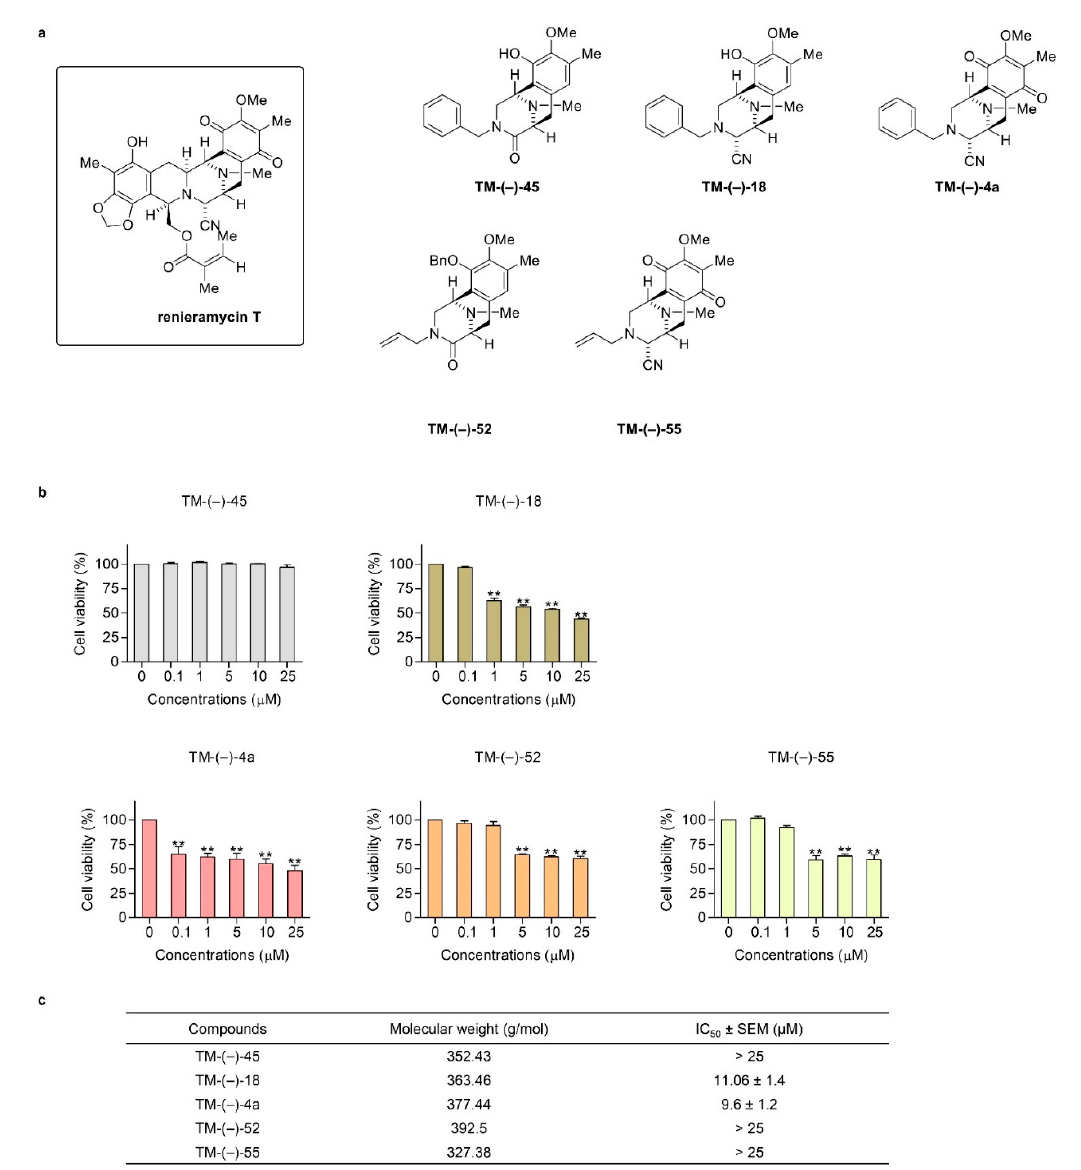
Figure 2. Cytotoxic effects of the simplified right-half model of RT compounds on the NSCLC cell line (H460). ( a ) The structures of RT and the simplified right-half model of RT compounds: TM-(–)-45, TM-(–)-18, TM-(–)-4a, TM-(–)-52, and TM-(–)-55. ( b ) The H460 cell line was treated with 0–25 µM of the compounds for 24 h. Then, the MTT assay was used to determine the percentages of cell viability. ( c ) IC 50 values in each cell line were calculated in comparison to the untreated control. Data represent the mean ± SEM ( n = 3) (* 0.01 ≤ p < 0.05, ** p < 0.01, compared with the untreated control).